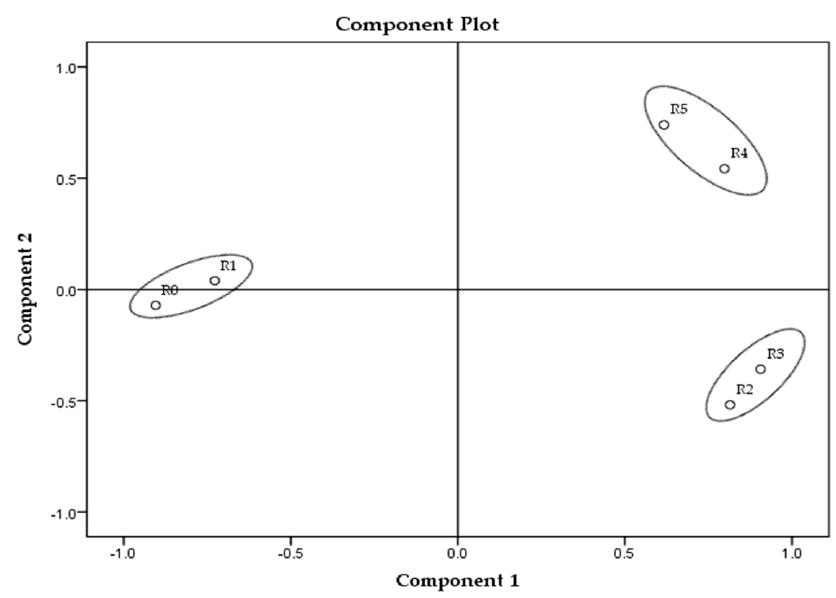
Figure 2. Principal component analysis of soap samples made of rapeseed oil. * Samples’ description is given in Table 1.